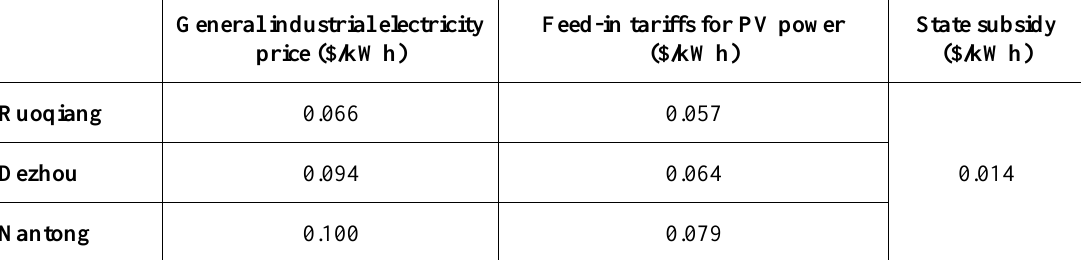
Table 3. The state subsidy, industrial electricity price, and on-grid price of PV generation in three typical cities.